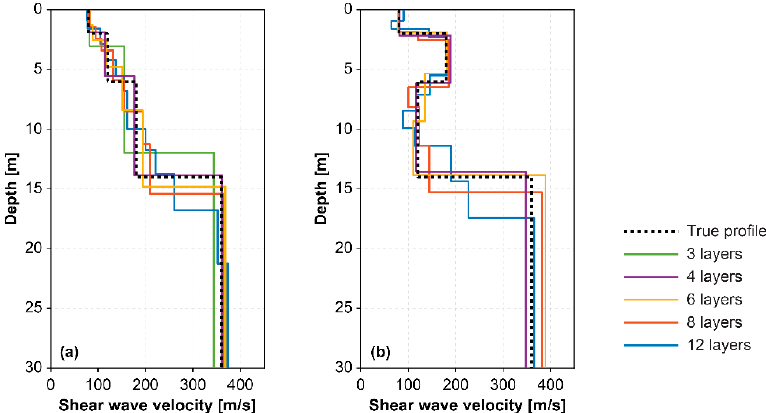
Figure 15. Comparison of shear wave velocity profiles obtained using different layering parameterizations for ( a ) model B and ( b ) model C.